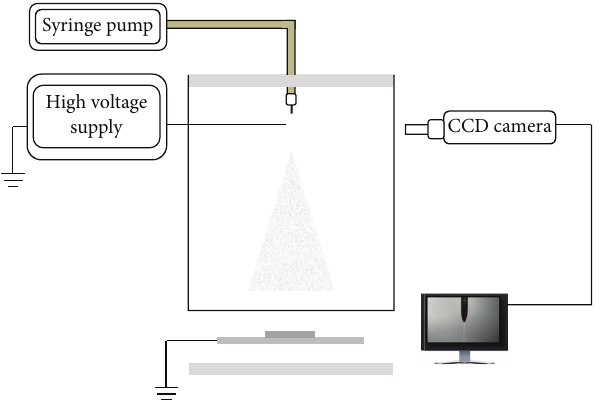
Figure 1: Electrostatic spray deposition experiment setup.